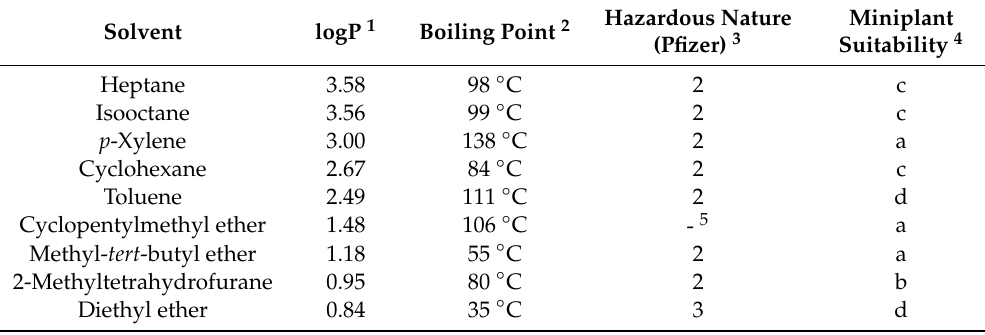
Table 2. Assessment of organic